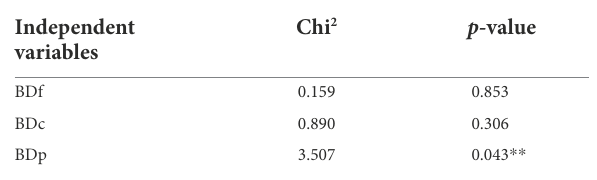
TABLE 8 Granger test